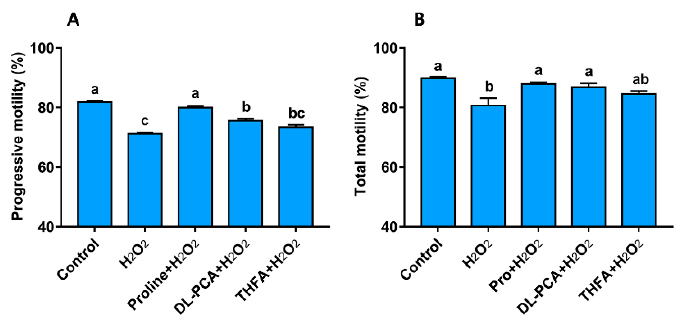
Figure 5. Effect of proline analogs on the progressive motility ( A ) and total motility ( B ) of boar sperm during H 2 O 2 exposure. Except for semen in the control group, all samples were incubated with 200 µ M H 2 O 2 at 37 °C for 2 h in the presence of different proline analogs (5 mM). Values are shown as mean ± SEM of three independent experiments. Columns with nonidentical lowercase letters are significantly ( p < 0.05) different from each other in statistics.